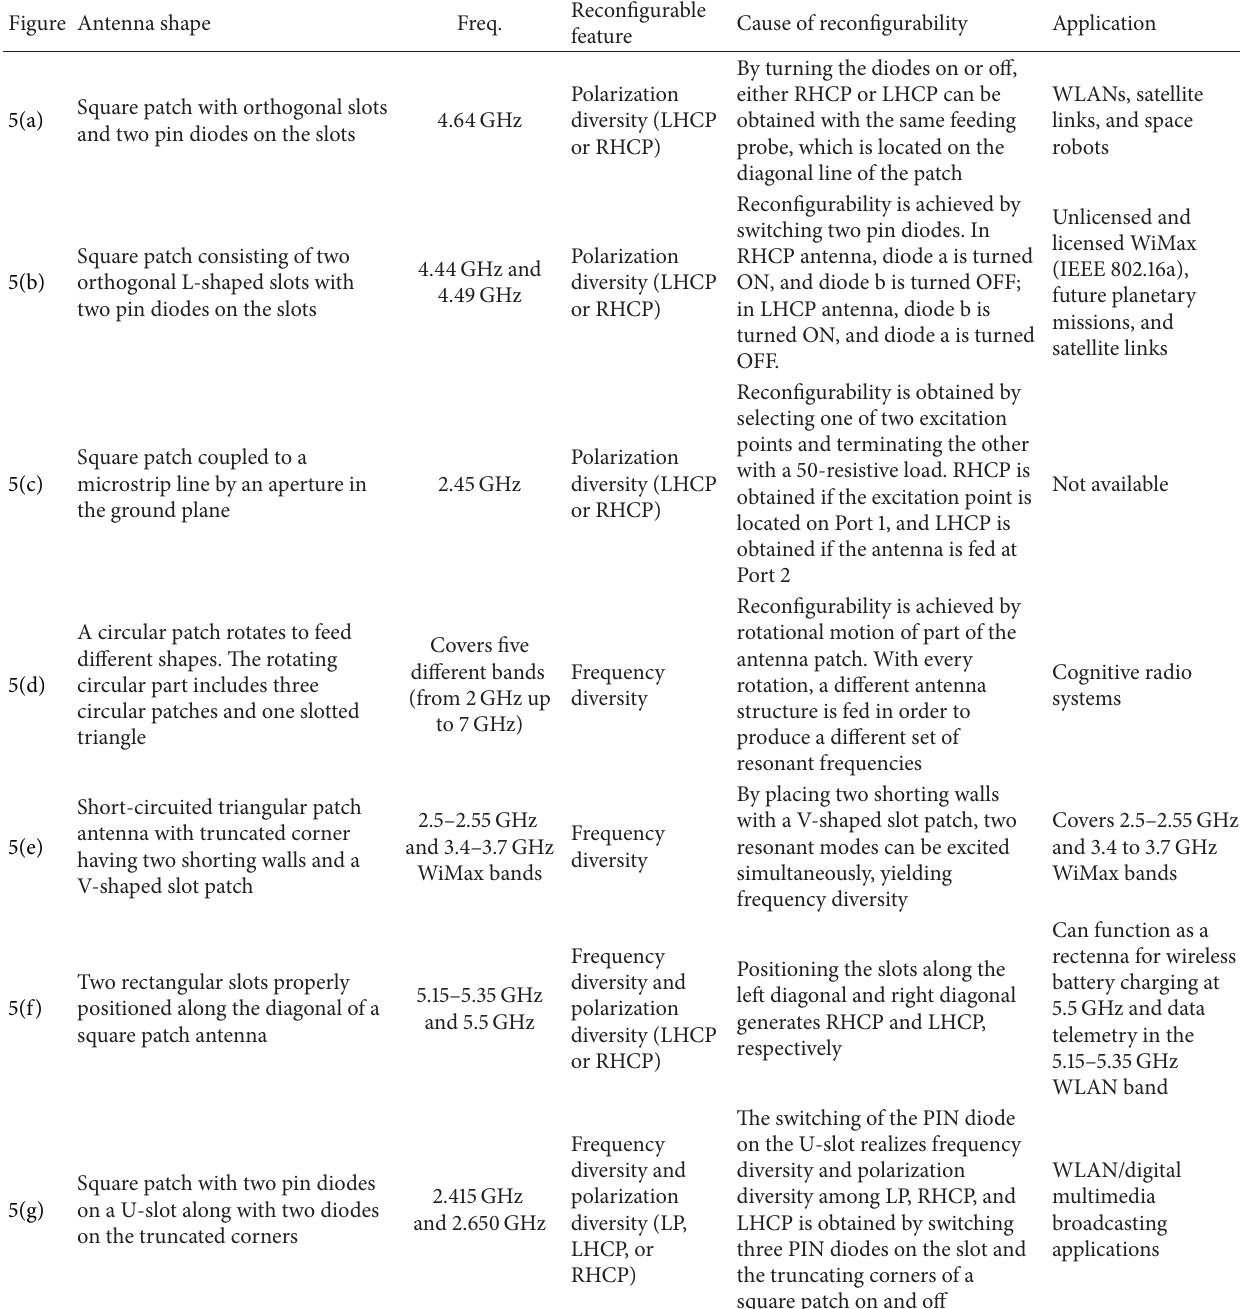
Table 3: Various antenna shapes and their